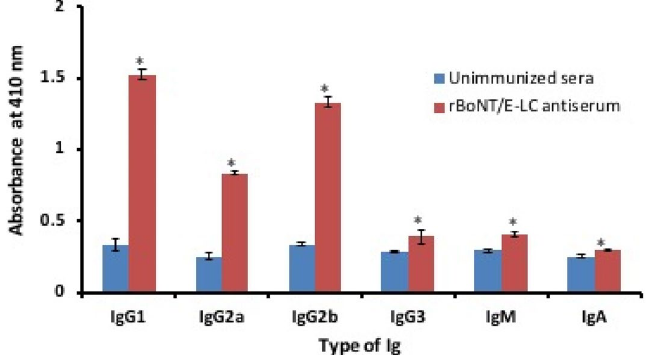
Figure 5. Antibody isotyping: Sera were collected 2 weeks after the last immunization and 1:2,000 dilutions were used. There is significant increase in titre of IgG subtypes in this order IgG1 > IgG2b > IgG2a and insignificant increase observed in IgM followed by IgG3 and IgA. The results are presented as the mean absorbance at 410 nm for each IgG isotype. *p < 0.05 represents statistically significant differences between the immunized and unimmunized